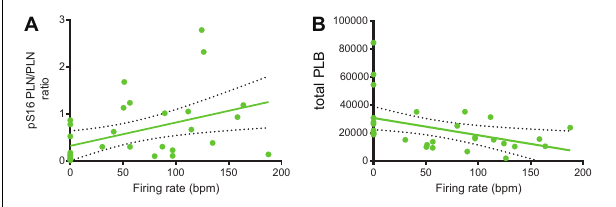
FIGURE 8 | The phosphorylated-PLB/total PLB ratios (A) and total PLB number (B) and were positively ( n = 32; Y = 0.004982X + 0.3209, p = 0.0132; R 2 = 0.188) and negatively ( n = 31; Y = –123.5X + 30723, p = 0.0161; R 2 = 0.184) associated with the firing rate,